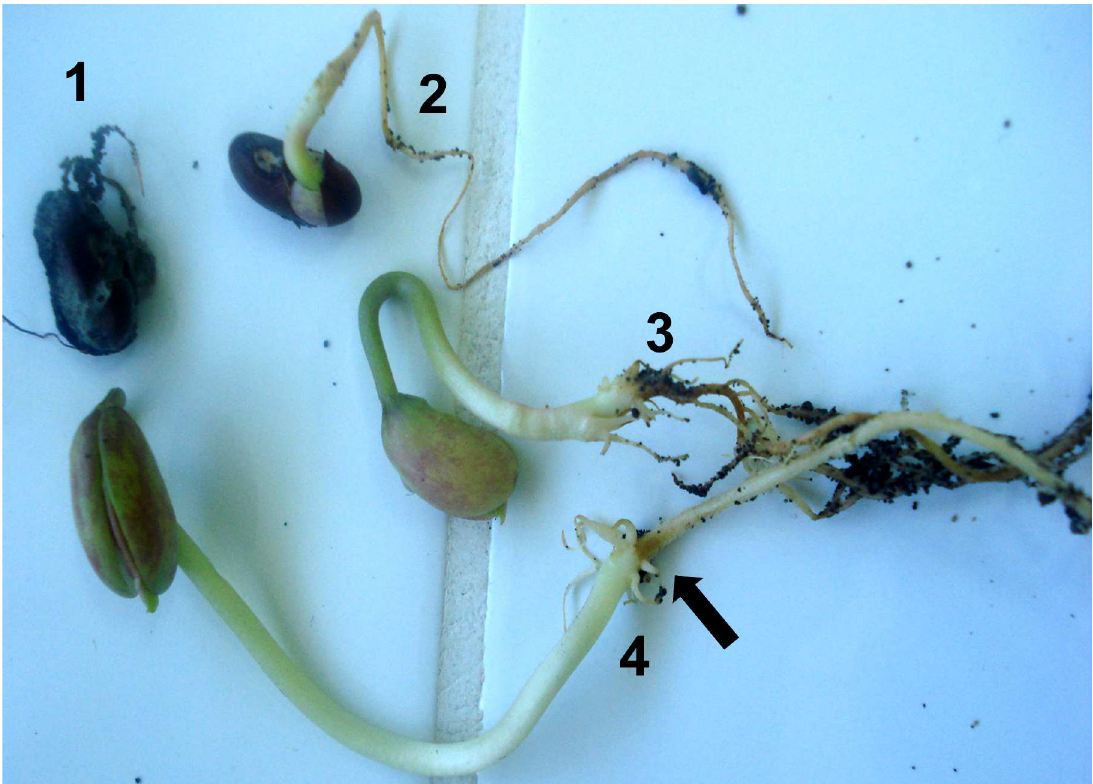
Fig 2. Types of symptoms in beans sampled from storehouses and grown in sterilized soil under controlled conditions. Plants were inspected15 days after planting.1, Early death of roots and the seedling;2, root rot and poor emergence of the seedling;3, necrosis in roots and poor growth of the seedling;4, discoloration(mild necrosis) at the neck of the tap root (indicated by the black arrow).